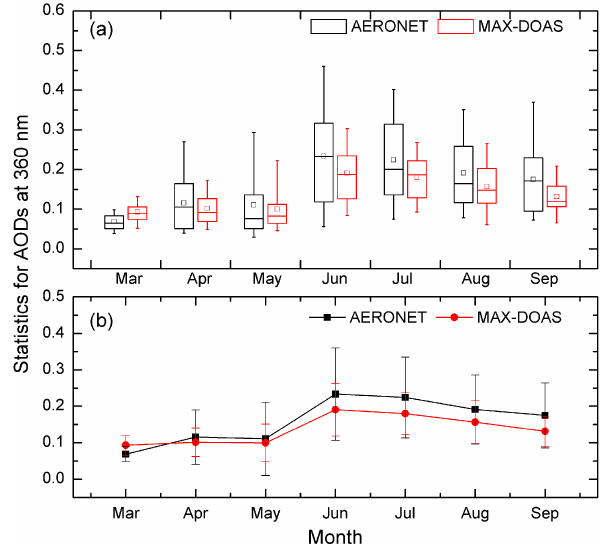
Figure 5. Statistics for monthly AODs at 360nm retrieved from MAX-DOAS and AERONET. The upper and lower boundaries of box indicate the 1st and 3rd quartile respectively. The whiskers show the 5th and 95th percentiles. Mean and median are represented with open square and centerline in the